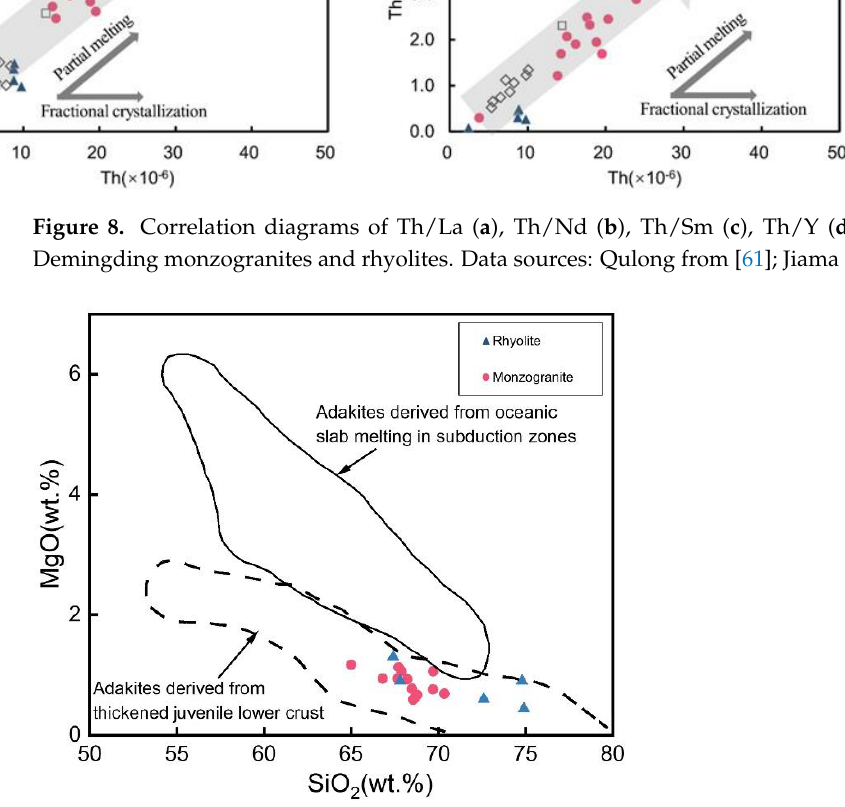
Figure 9. The plots of MgO versus SiO 2 field for the Demingding monzogranite and rhyolite, after [63].